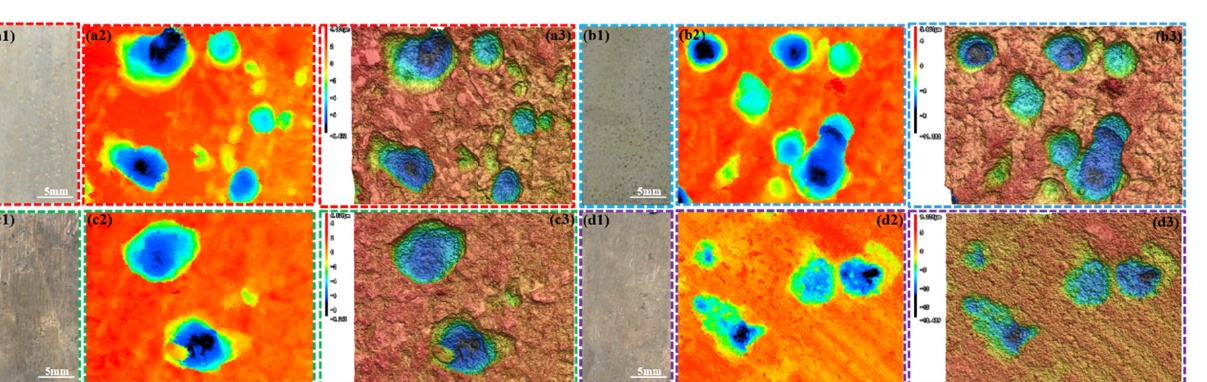
Figure 11. Macro ‐ morphology and micro ‐ morphology of T95 steel used for packer in gas ( a , b ) and liquid ( c , d ) phase.